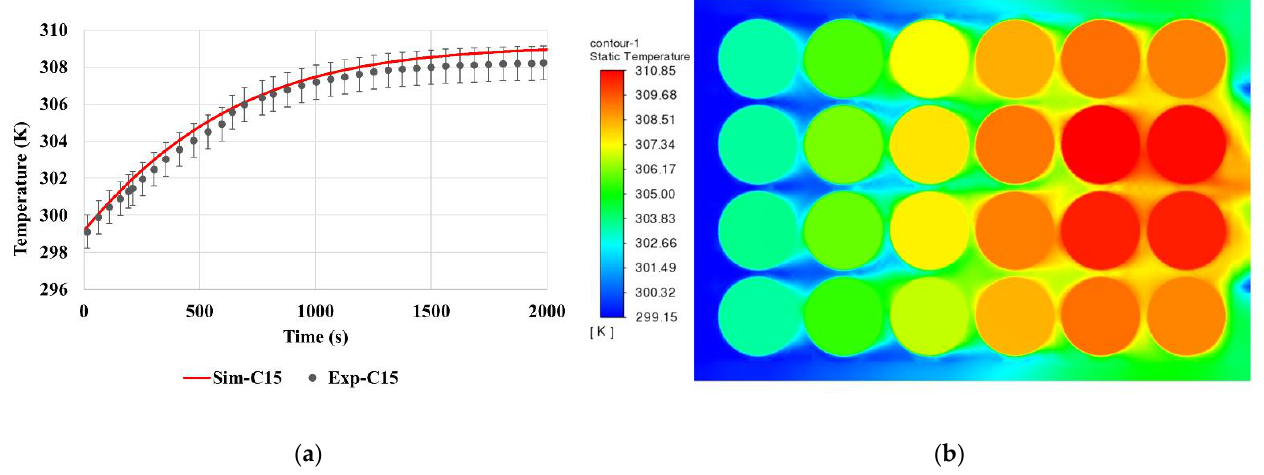
Figure 4. ( a ) Numerical model validation, the error bar is 0.3%; ( b ) Temperature distribution in the cross-section plane.